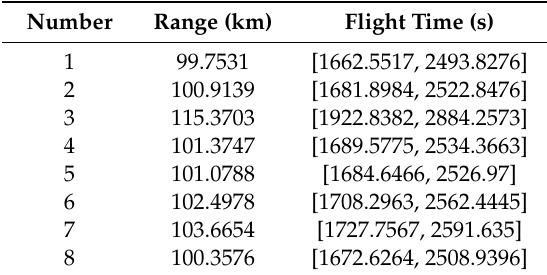
Figure 11. The result of case 4. ( a ) 3D UAV cooperative path map; ( b ) contour map of cooperative path; ( c ) convergence curve of each UAV; ( d ) path cost convergence curve. Table 16. Range and flight time of each aircraft (case